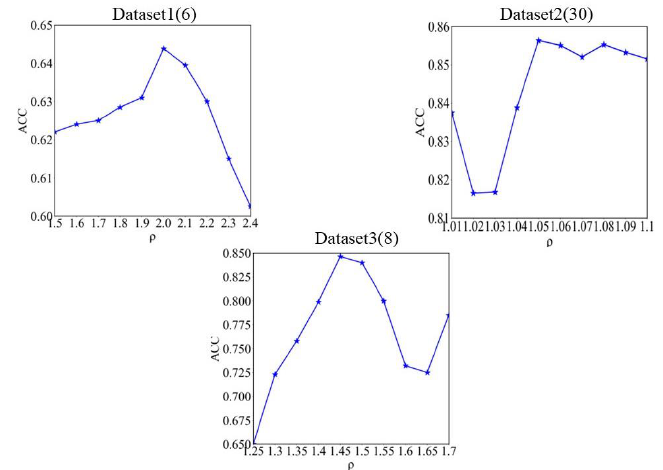
Figure 6. The effect of ρ